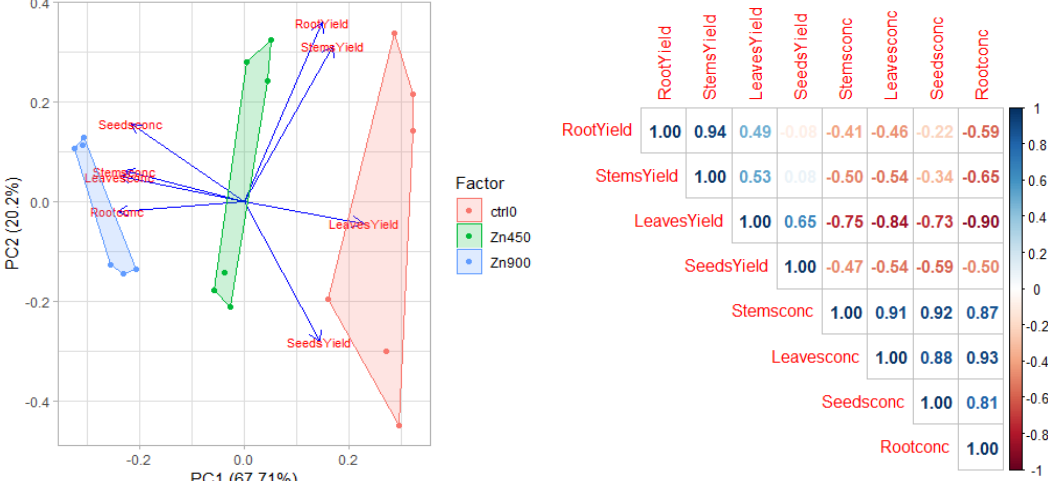
Figure 10. Principal component analysis and correlation matrix in zinc-contaminated soil in the two